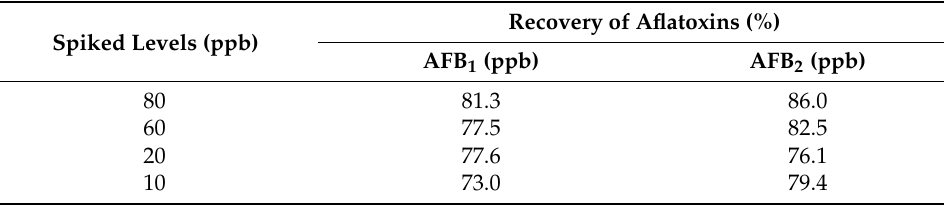
Table 2. The recovery percentage of spiked aflatoxins from A. flavus